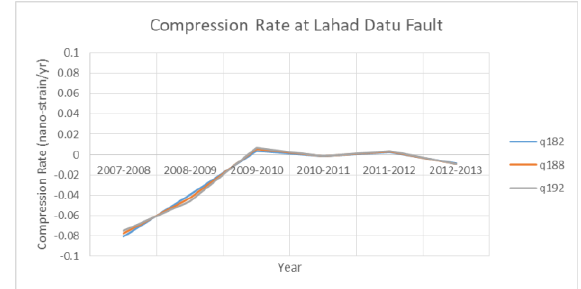
Figure 23 Compression rate changes on Lahad Datu Fault’s Quasi Network points (q182, q188 and q192) from 2007 to